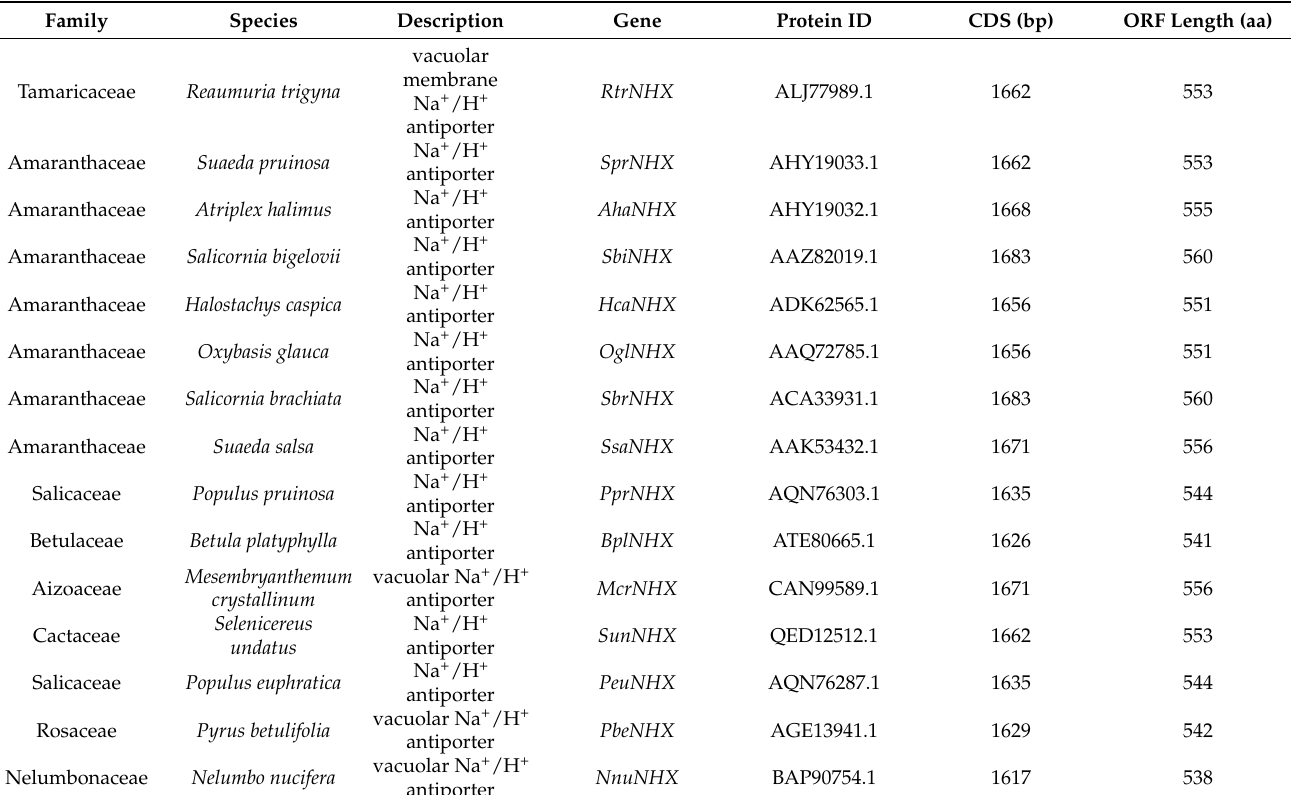
Table 5. Information sheet for 15